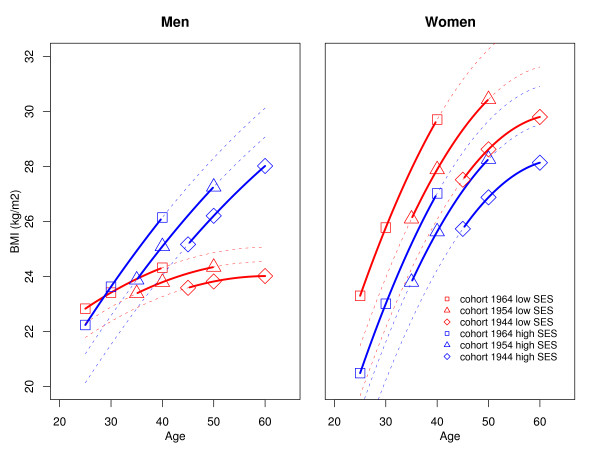
BMI trajectories according to age, birth cohort and socio-economic status category in men and women, as predicted by linear regression. Models are also adjusted for smoking status and include a quadratic term for age and interaction terms between SES and age and between SES and cohort (year of birth)